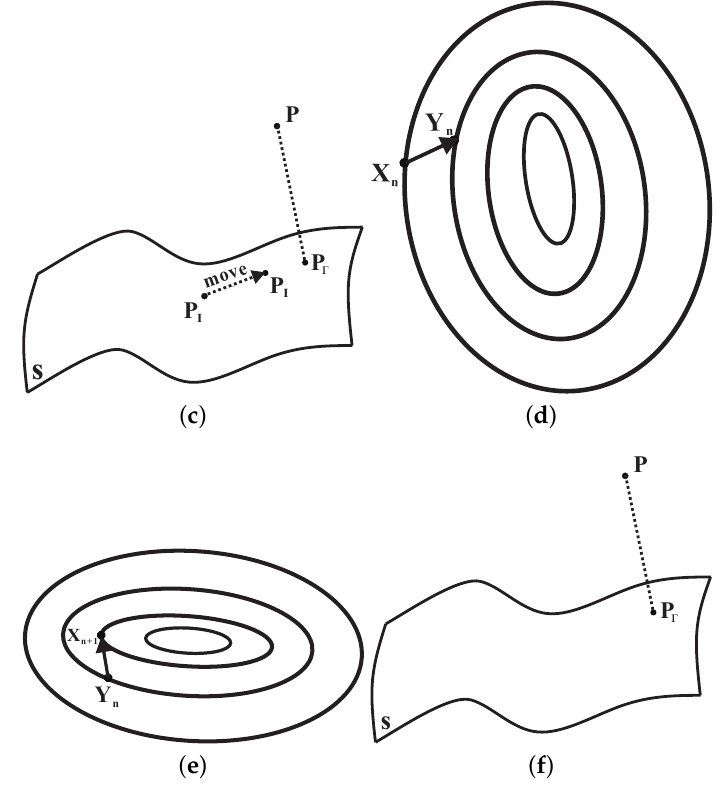
Figure 5. The complete graphic demonstration of Algorithm 4. ( a ) Newton’s gradient descent method unrelated to test point; ( b ) Computing foot-point Q of Equation (14); ( c ) Moving the iteration point P I to a position near the orthogonal projection point P Γ in for loop body of Algorithm 2; ( d ) Newton’s gradient descent method, unrelated to test point of the first formula in Equation (15); ( e ) Newton’s gradient descent method, associated with test point of the second formula in Equation (15); ( f ) Point orthogonal projection onto algebraic surface. All the curves of figures ( a , d , e ) are contour surfaces and not contour